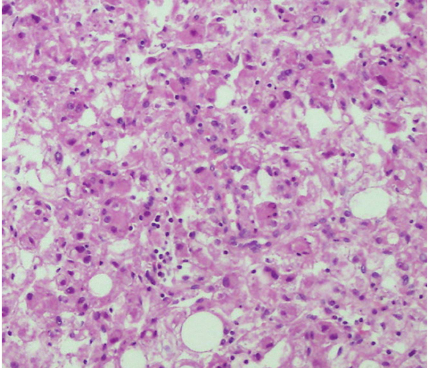
Figure3:Hematoxylin-eosinstainingofthesamelesionisdepicted. Large epithelioid cells show pleomorphism with large hyperchro- matic nuclei and abundant eosinophilic cytoplasm in epithelioid angiomyolipoma are demonstrated. Same image also contains fatty tissue that corresponds with subcapsular adipose component of the